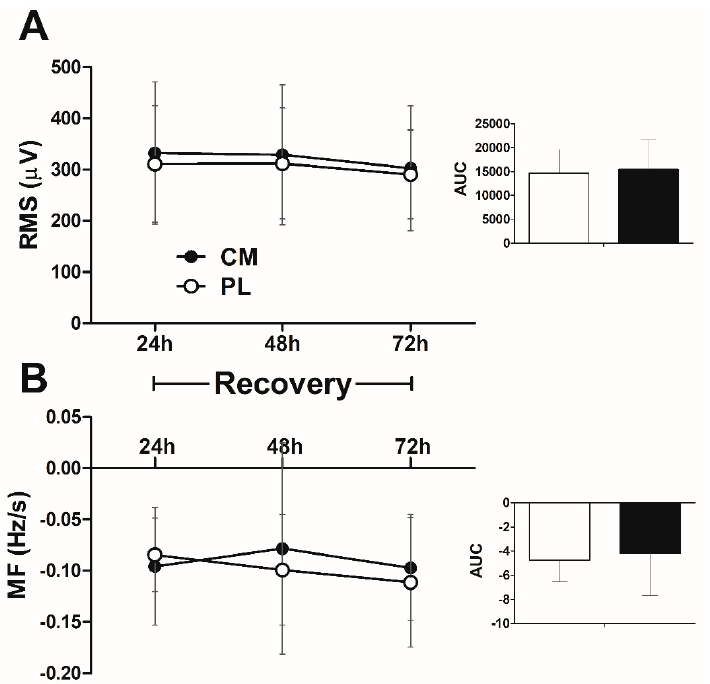
Figure 5. RMS ( A ) and MF ( B ) values in the leg press fatigue test at 24, 48, and 72 h after exercise session. Citrulline malate (CM), Placebo (PL). Right figure indicates the area under curve (AUC) for the three-day recovery period. (Repeated-measures ANOVA: time p > 0.05; treatment × time p > 0.05). Data are means ± SD.